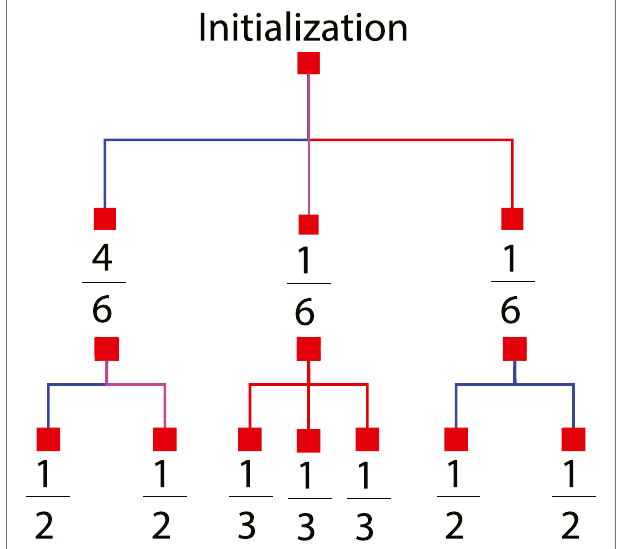
init , T r , D , T s , Map, k )